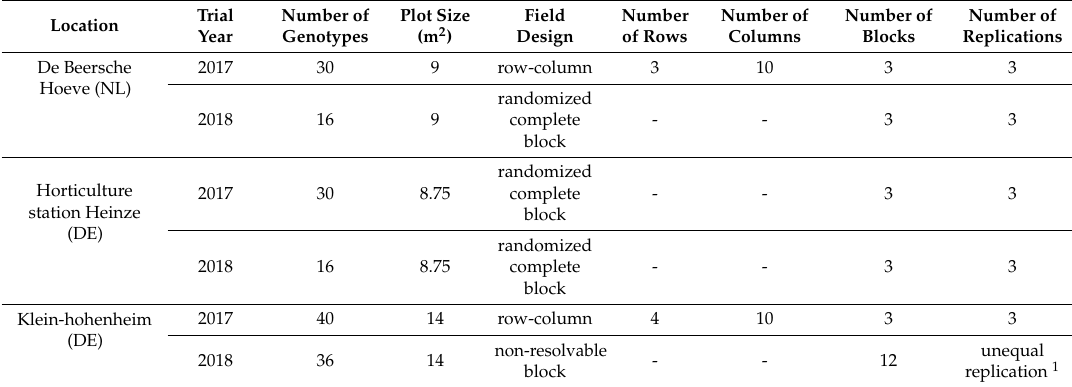
Table A1. Detailed information on the six conducted field trial in 2017 and